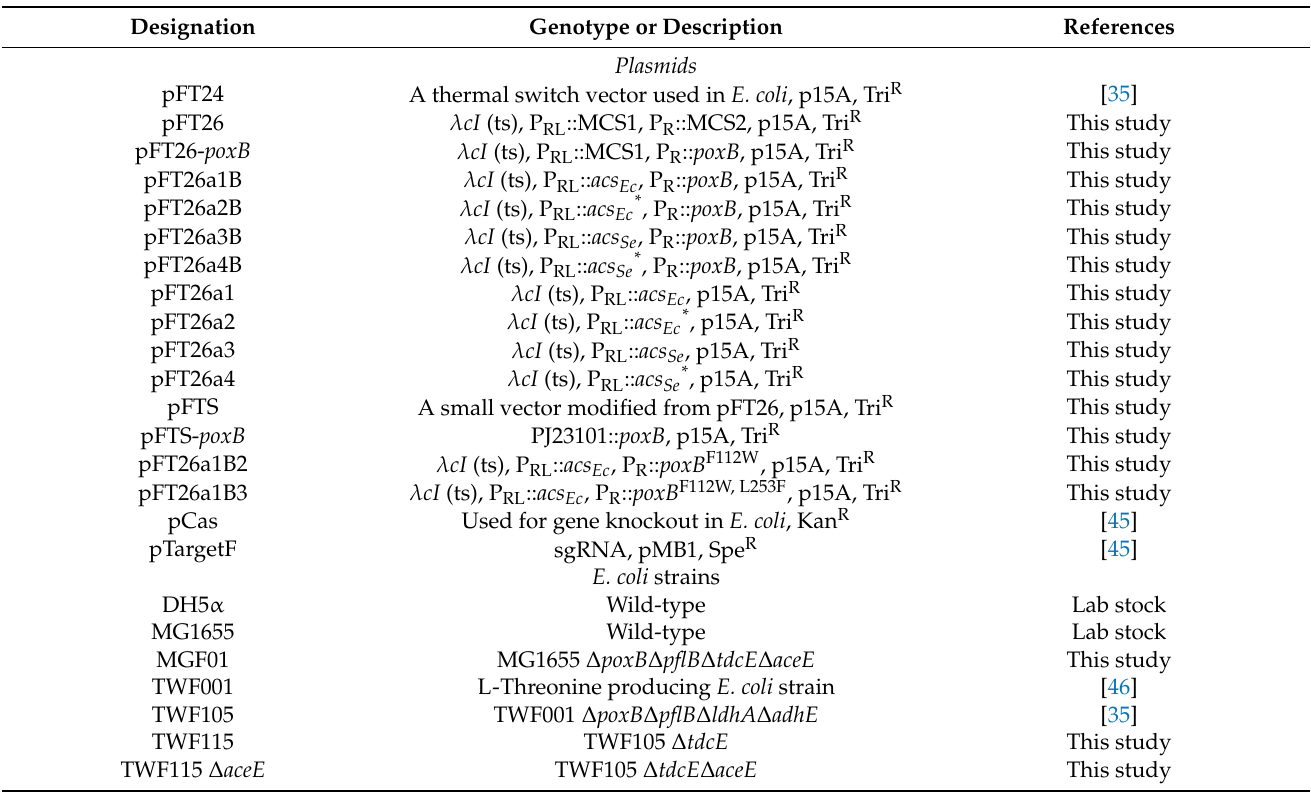
Table 4. Strains and plasmids used in this